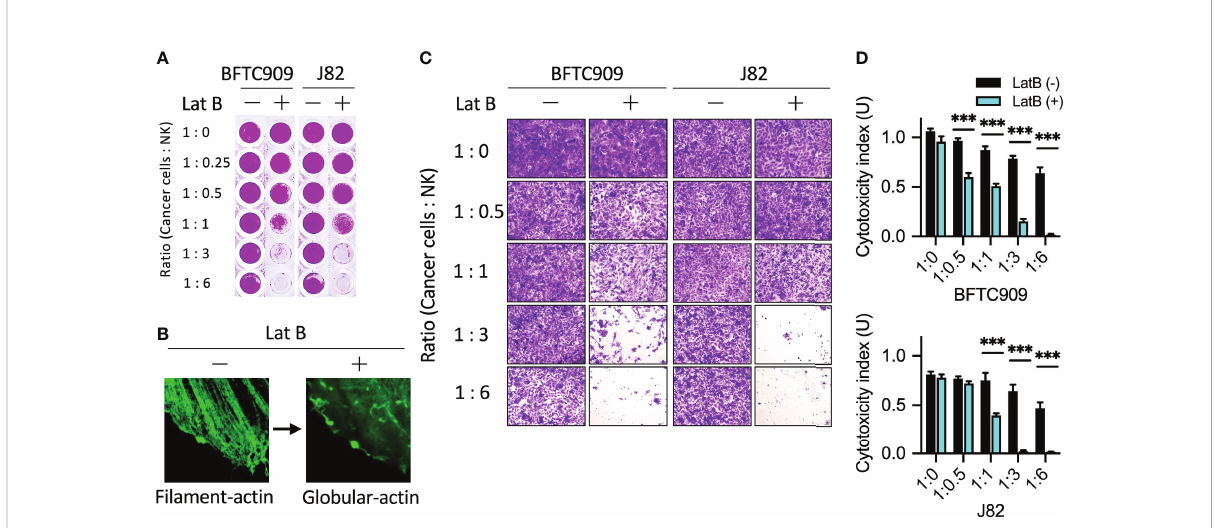
FIGURE 7 Disruption of actin fi laments formation enhanced NK cell-mediated cell death. (A) Pretreatment of latrunculin B, an actin fi laments inhibitor, increased NK cytotoxicity using urothelial cancer cells. Cells were seeded in the 96-well plate and pretreated with 0.5 µM latrunculin B for 6